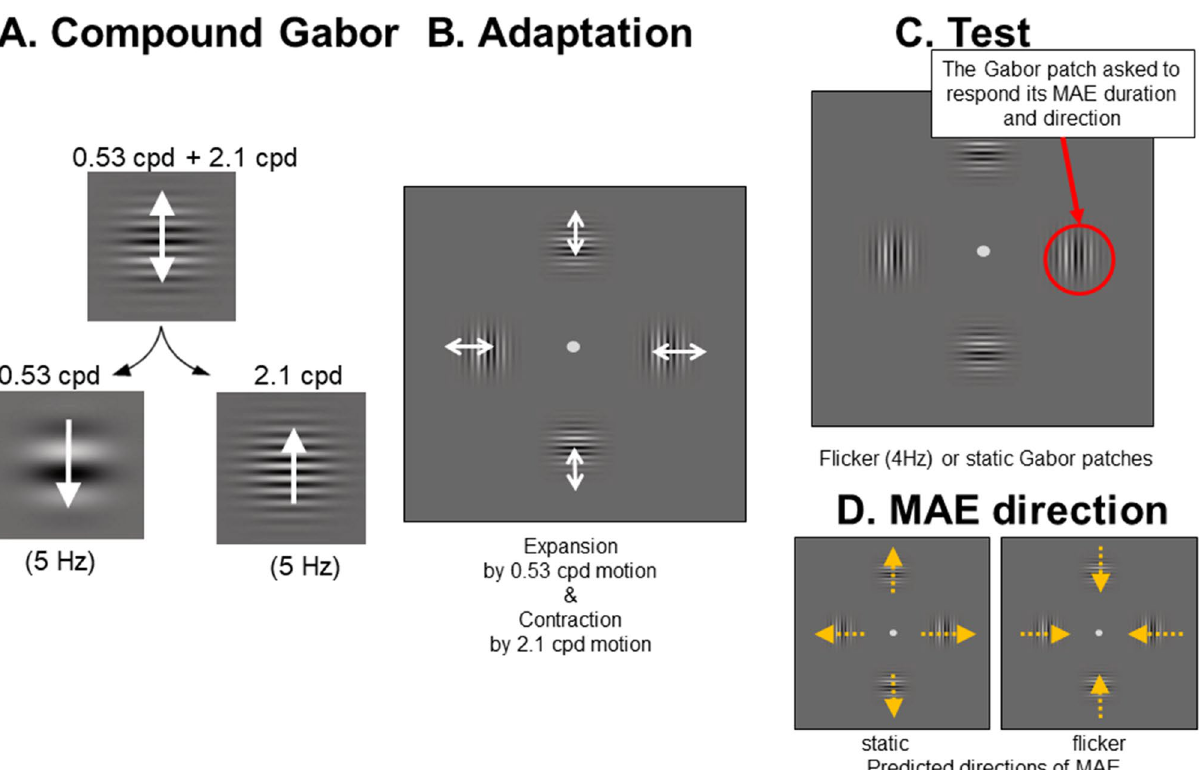
Figure 1. Stimuli used. ( A ) Each compound motion element was superimposed with two sinusoidal gratings: one at a spatial frequency of 0.53 cpd and the other at 2.13 cpd. The two gratings drifted within the Gabor patch in opposite directions at 5 Hz. For the superimposed Gabor patch, participants reported perceiving the motion direction of the 0.53 cpd grating. ( B ) Four component Gabor patches at fixed locations (above, below, to the left, and to the right of the central fixation) were presented during the adaptation period. The arrow in the example showed the motion directions of the 0.53 cpd grating. When the motion elements were integrated across all locations, the participants perceived global expansion. ( C ) During the test period, four Gabor patches at the same locations in the adaptation period either flickered at 4 Hz or were static. The participants responded to both the perceived direction and the duration of the perceived motion. ( D ) MAE direction can be predicted as shown from the previous study. (Note: the color of the grating was modulated along yellow with a yellow